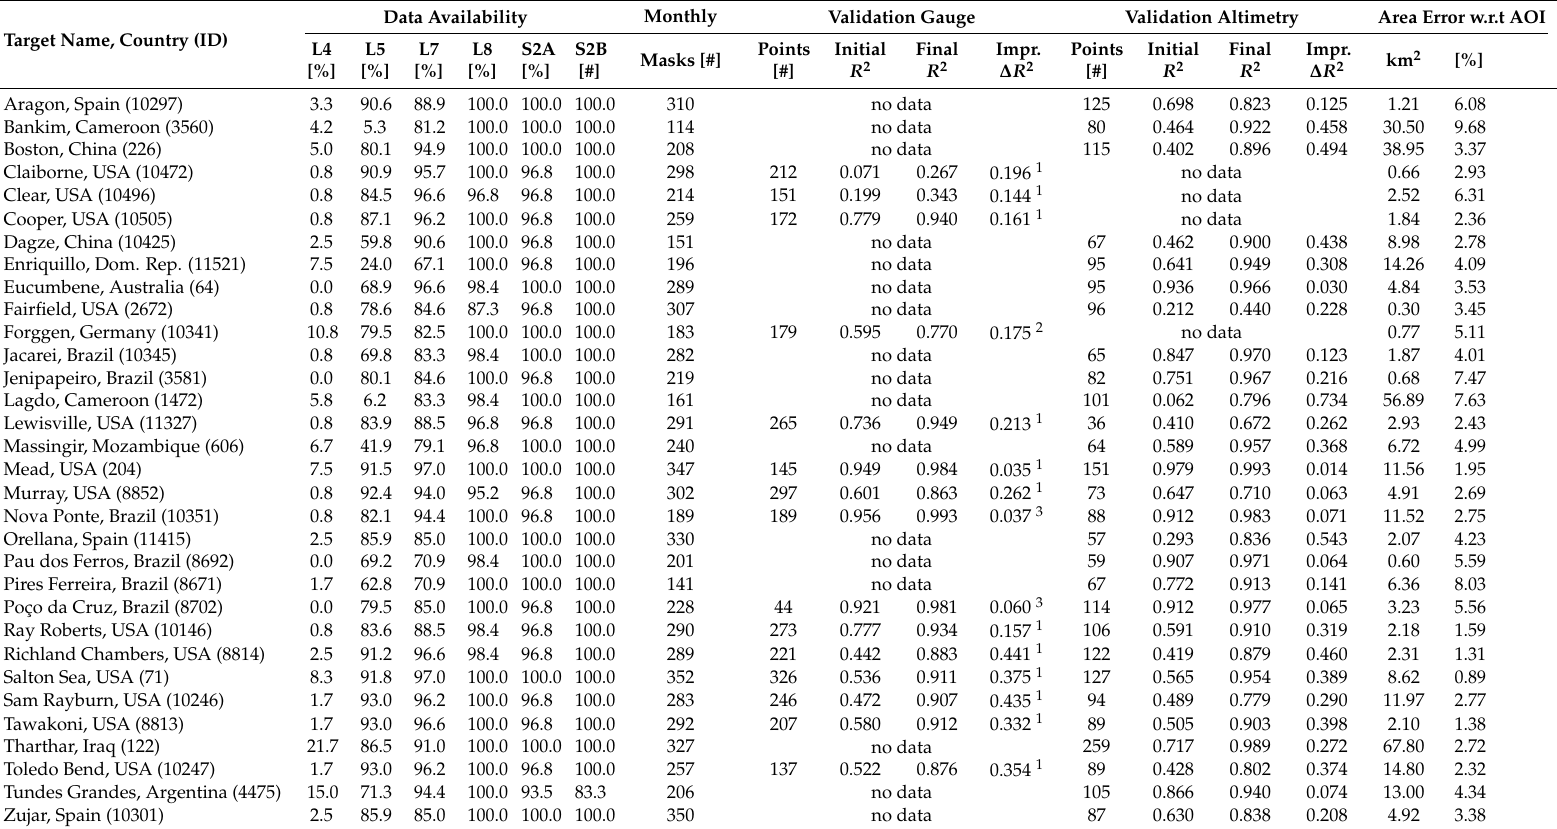
Table 5. Results for 32 selected study areas. For each study area, the data availability of the Landsat and Sentinel-2 and number of resulting monthly surface area masks. Furthermore, the validation results with in situ data and satellite altimetry (Number of used months, correlation with initial surface areas with gaps and with final surface areas, improvement of the new approach ) are presented in detail. Additionally, the average area estimates for each study area is